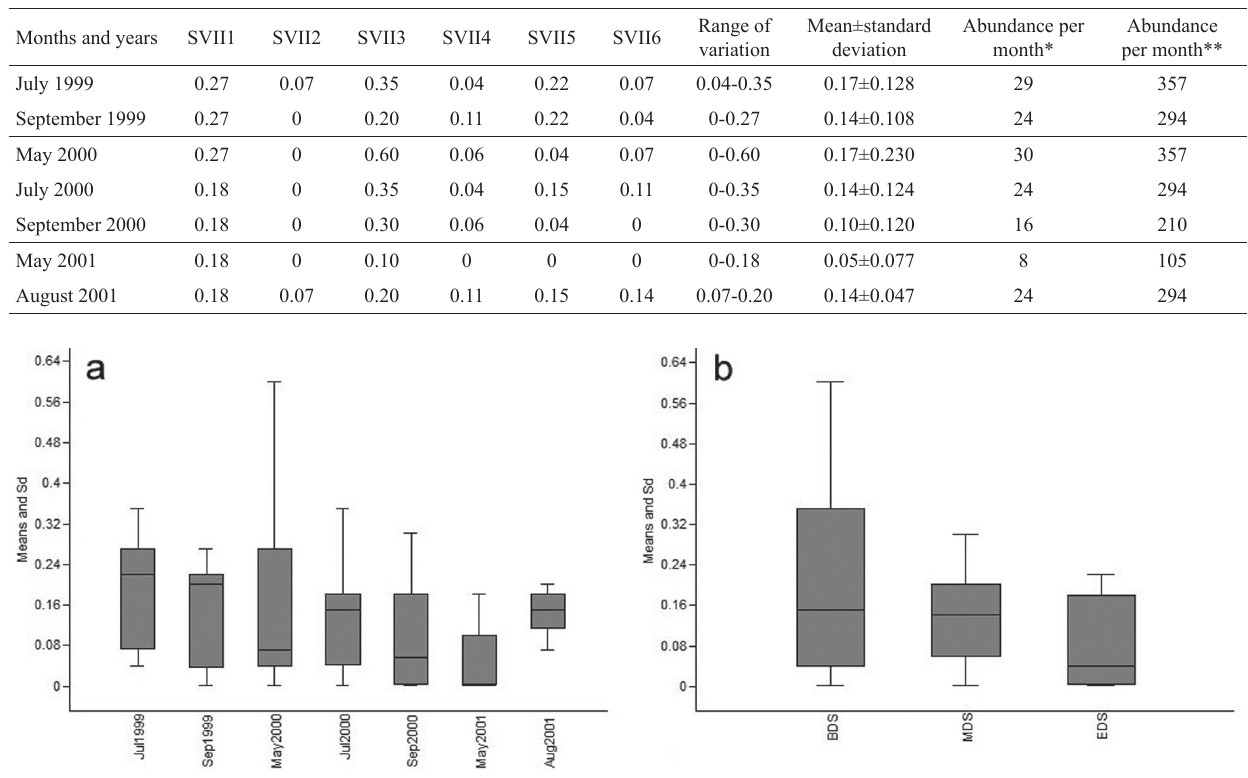
Fig. 4 . Box-plots showing the means and standard deviations (Sd) of population densities data for Eigenmannia vicentespelaea along the years 1999, 2000 and 2001 ( a ) and between the dry seasons, independent of the years ( b ) BDS, beginning of dry season; MDS, middle of dry season; EDS, end of dry